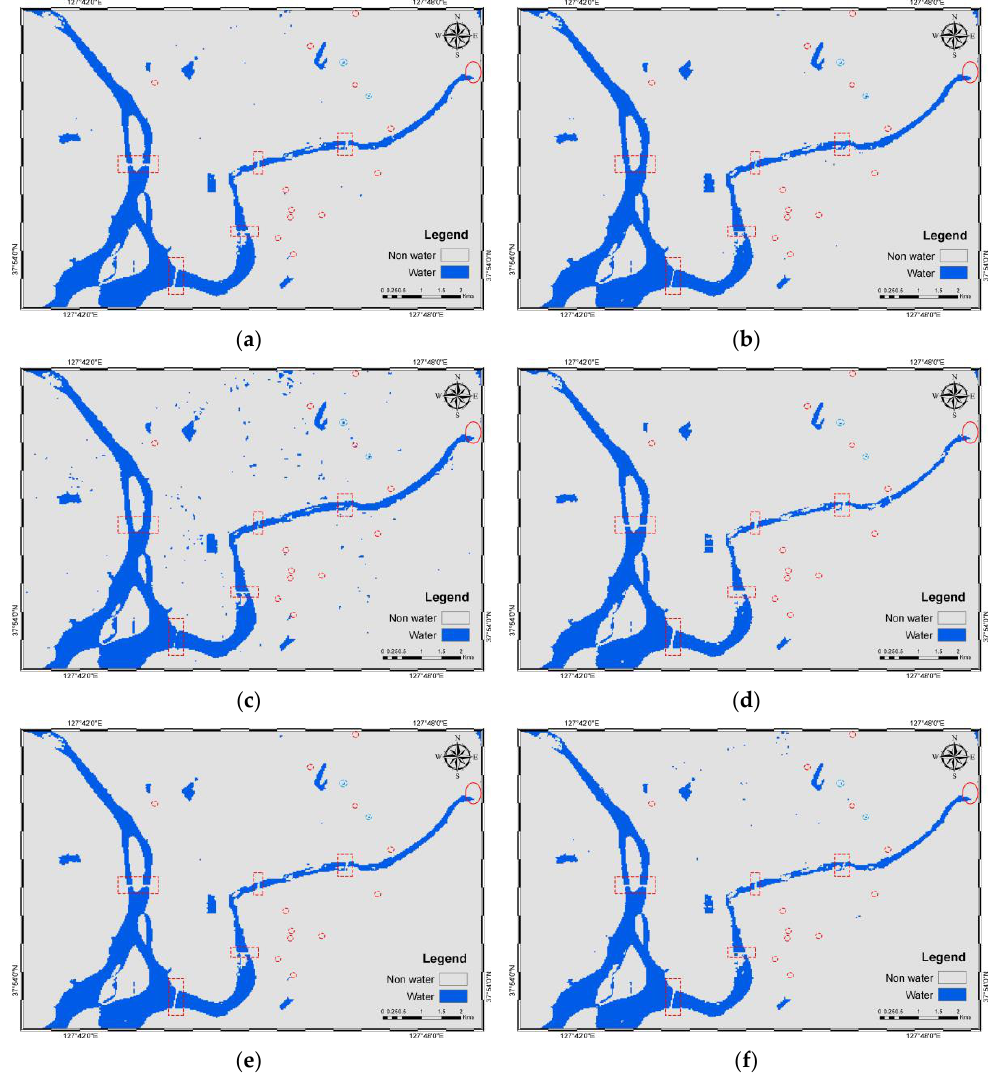
Figure 5. Enlarged section of the study area with smaller water bodies in a complex urban area and a lake with bridges: ( a ) Density Slicing; ( b ) NDWI; ( c ) MNDWI; ( d ) ML; ( e ) SVM; and ( f ) JDT. The red dotted boxes, red oval, red dotted circles and light blue dotted circles show bridges, a dam, unidentified water bodies and identified water bodies, respectively.